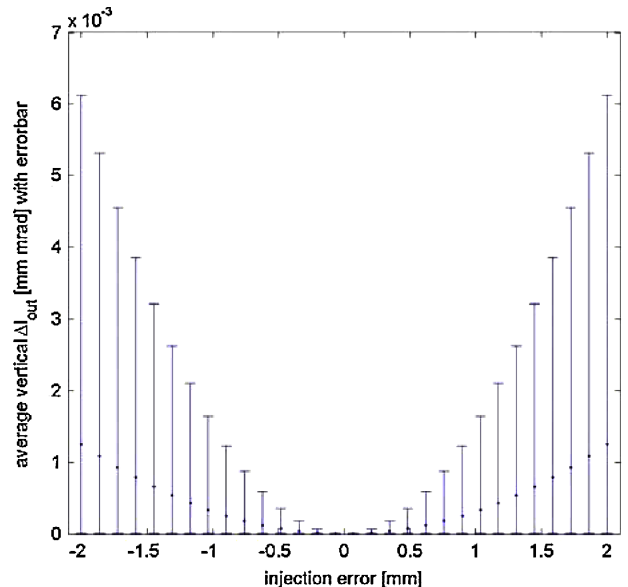
FIG. 25. Average bunch centroids CSI calculated with respect